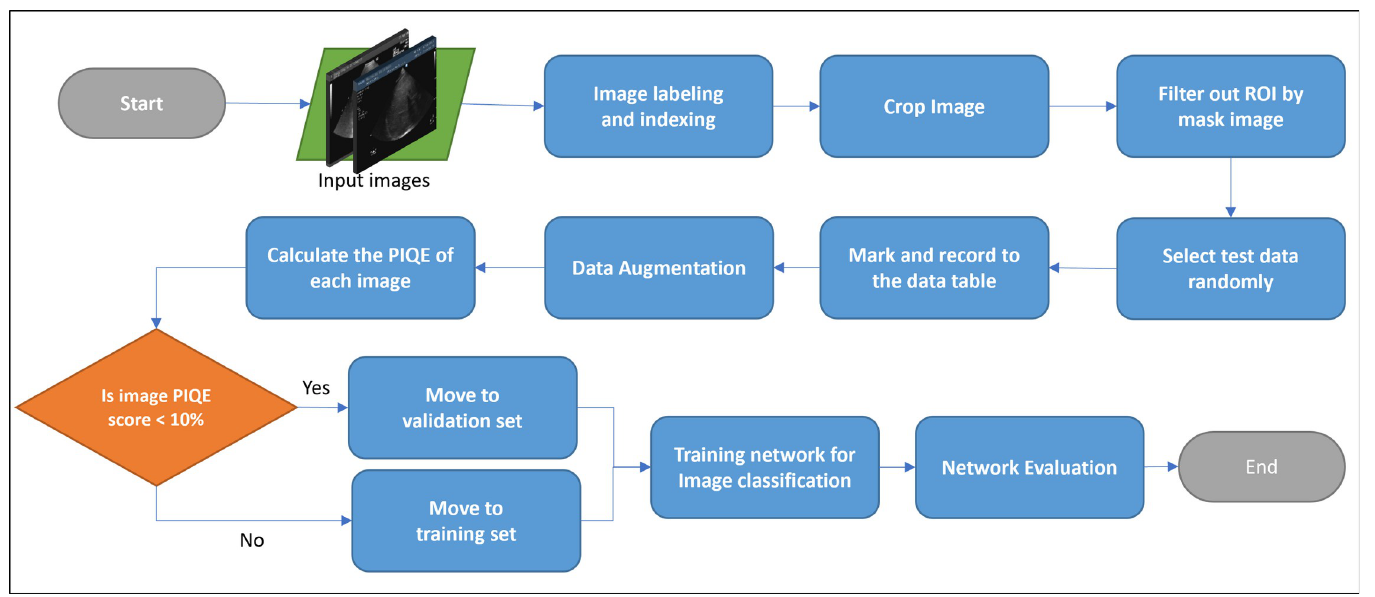
Fig 1. Workflow chart of neural network training for US image recognition. ROI: range of interest. PIQE: perception-based quality evaluator.